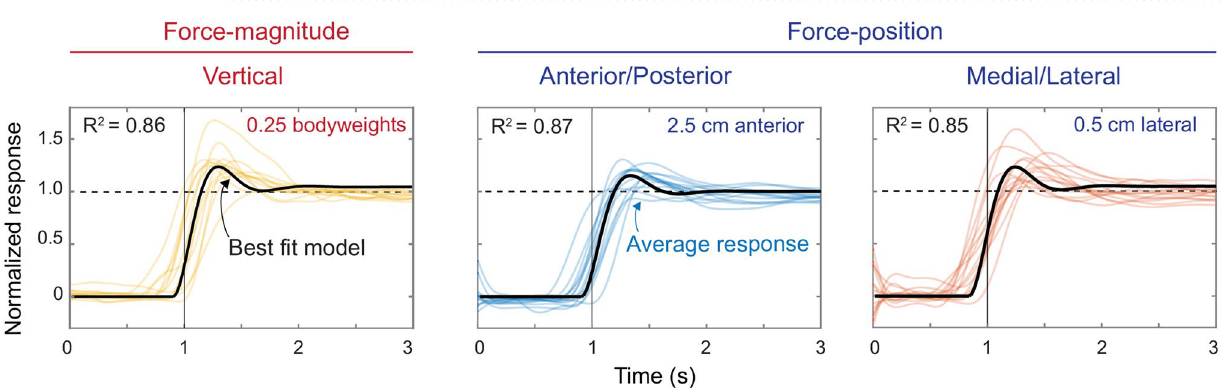
Figure 6. Representative modelling results for select force-magnitude and force-position target step size conditions. We plotted the second-order model using the average of the best-fitted parameters (black line) against the average of each participant’s response to each step target magnitude (colored lines). The vertical line represents when the step function steps up from zero to the normalized target value of one. The horizontal dashed line is the target step size value of 1. The R 2 value shown is the average fit of the model for that